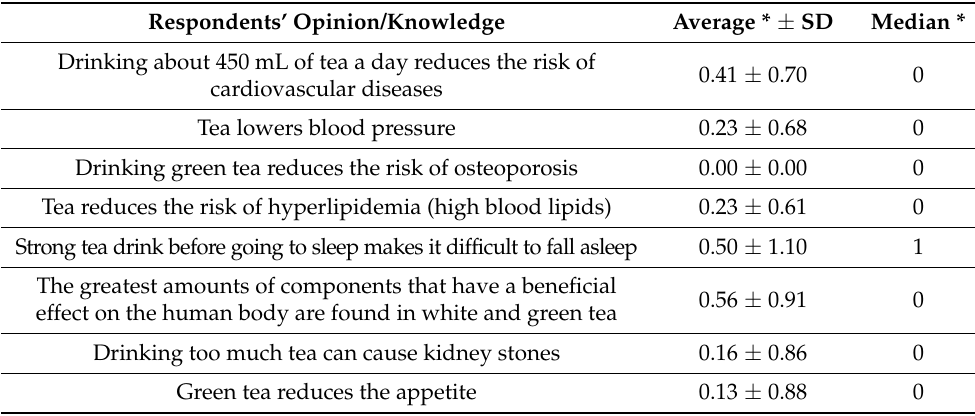
Table 4. Respondents’ opinion about